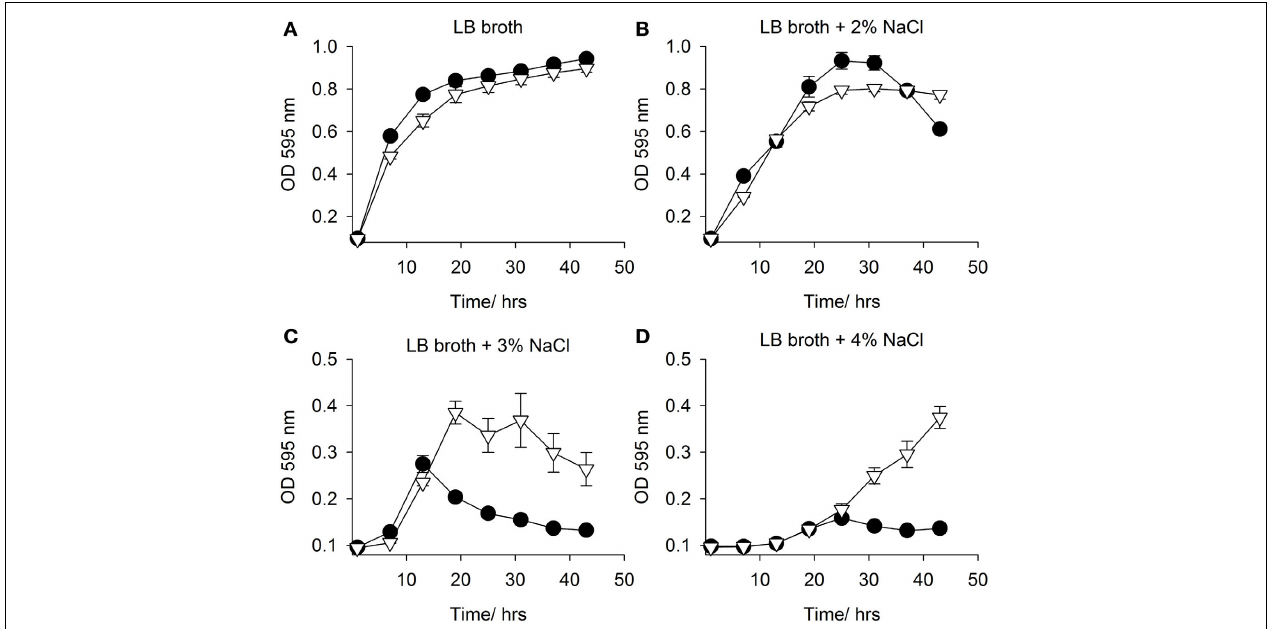
FIGURE 5 | Growth in LB broth with NaCl. Growth in of E. coli MKH13::pCI372 ( • black circle) and MKH13::pCI372- sdtR ( (cid:2) open triangle) in (A) LB broth and LB broth supplemented with (B) 2% NaCl, (C) 3% NaCl and (D) 4% NaCl.